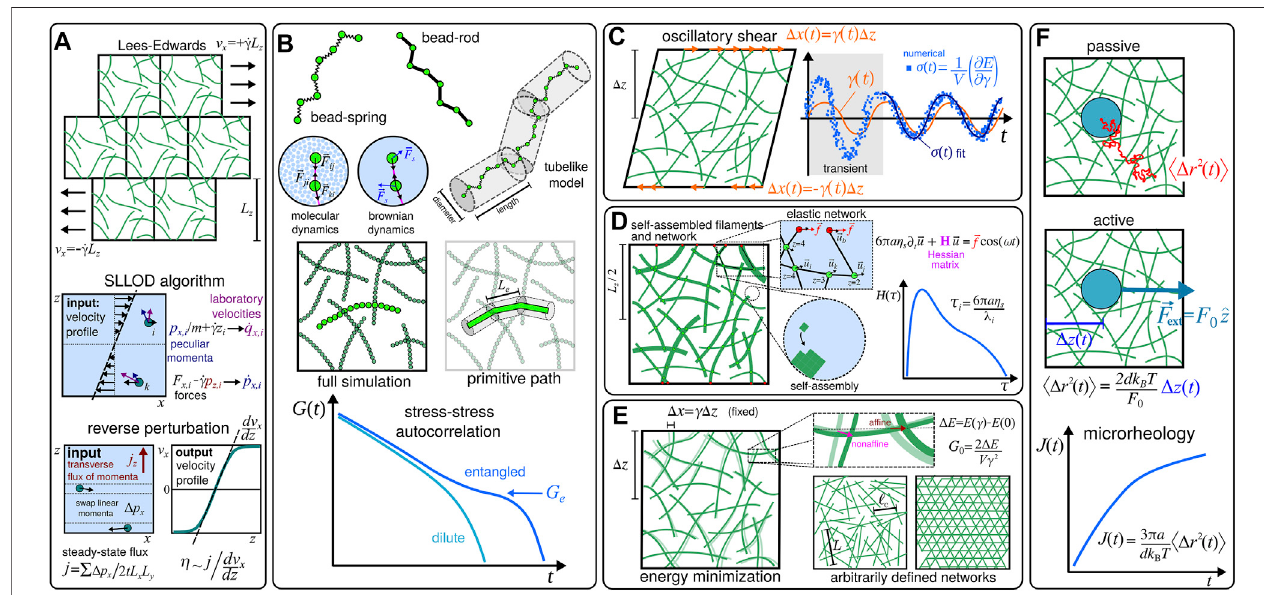
FIGURE2| Examplesofcomputationalparticle-basedmethodsusedtoestimatethemechanicalpropertiesofbiopolymermaterials. (A) Shear fl owconditionscan be implemented through Lees-Edwards [19] driven boundary conditions [40], and other related methods, e.g., the SLLOD algorithm [40, 41], and the reverse perturbation method [42, 43], in order to evaluate the viscosity η 0 at low shear rates _ γ , i.e., η 0 ≈ lim _ γ → 0 η ( _ γ ) . (B) Bead-spring and bead-rod coarse-grained fi lament models[44]usedtosimulatesystemswithasingleormultiplechains.Fullsimulationsatisothermalconditionscanbecarriedouteitherthroughmoleculardynamics (MD) simulations [45], where particles have thermostated degrees of freedom (e.g., peculiar momenta (cid:2) p i ), or through stochastic simulations, which include mesoscale approaches like [40], e.g., multi-particle collision dynamics [46] (MPCD), dissipative particle dynamics (DPD), and Langevin/brownian dynamics (BD), where solvent effectsareimplementedthroughstochasticforces (cid:2) F s .Inanycasetherelaxationmodulusforbothdiluteandentangledsolutionscanbeevaluatedas G ( t )= 〈 σ xy ( t ) σ xy (0) 〉 / k B T , where σ xy ( t ) denote entries of the stress tensor [15] which are given in terms of relative positions (cid:2) r ij ( t ) and forces (cid:2) F ij ( t ) between all particles in the system [47]. Alternatively, the entanglement modulus G e can be effectively determined from the properties of primitive paths [28] de fi ned by tubelike regions of length L e that are obtained by considering that all the other chains are frozen [29]. (C) As discussed in Ref. [31], one can implement an oscillatory shear setup by imposing a time- dependentstrain γ ( t )= γ 0 sin( ω t ),and,afteratransientperiod, fi tthenumericallyobtainedstress σ ( t ) ≈ (1/ V )( z E / z γ )toasinusoidalfunction σ ( t )= σ 0 sin( ω t + δ ),whichyields G ′ ( ω ) = ( σ 0 / γ 0 )cos( δ ) and G ′′ ( ω ) = ( σ 0 / γ 0 )sin( δ ). (D) Effective elastic network formed from self-assembled fi laments with different thicknesses [38]. Displacements (cid:2) u ( t ) of the crosslinks in the steady-state regime are obtained from the overdamped equations so that the eigenvalues of the Hessian matrix H can be related to the